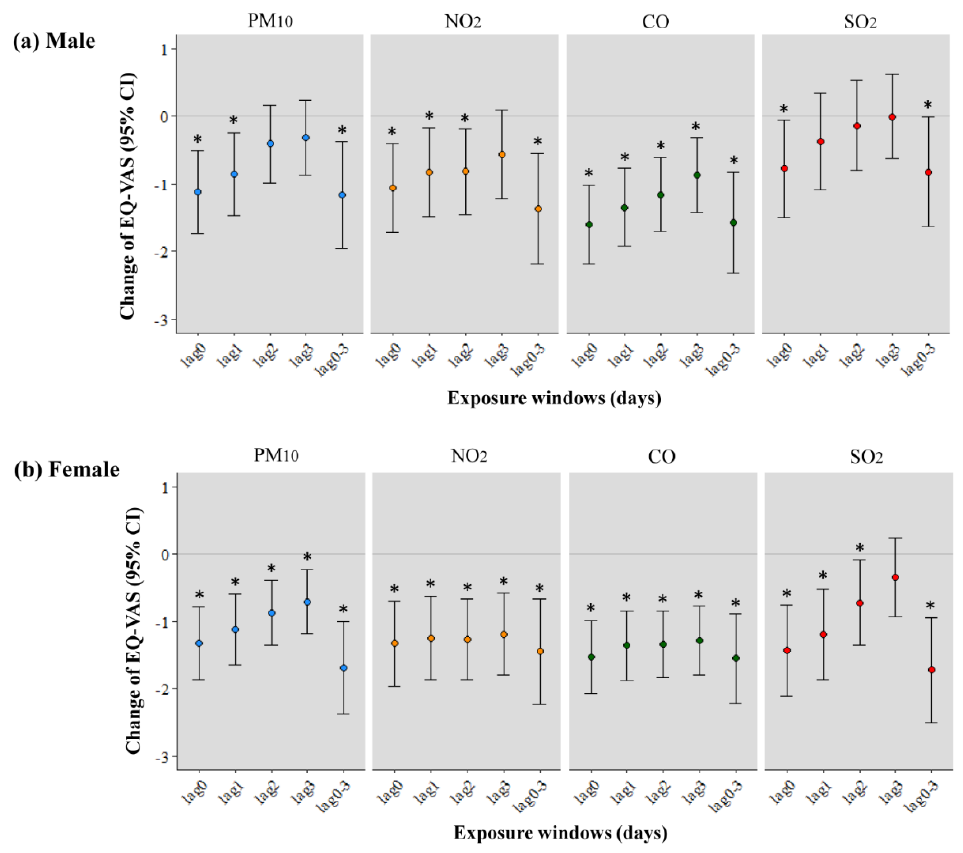
Figure 2. Association between changes in the EQ-VAS scores per interquartile range increment of PM 10 , NO 2, and SO 2 in ( a ) males aged 40–49 years and ( b ) females aged 50–64 years with chronic diseases. * p -value < 0.05. The model is adjusted for age, education, income, marital status, smoking, alcohol consumption, economic status, and sleeping time. PM 10 , particulate matter measuring <10 µm in diameter; NO 2 , nitrogen dioxide; SO 2 , sulfur dioxide; IQR, interquartile range; CI, confidence interval; lag0 – 3, moving average 0 to 3 days.